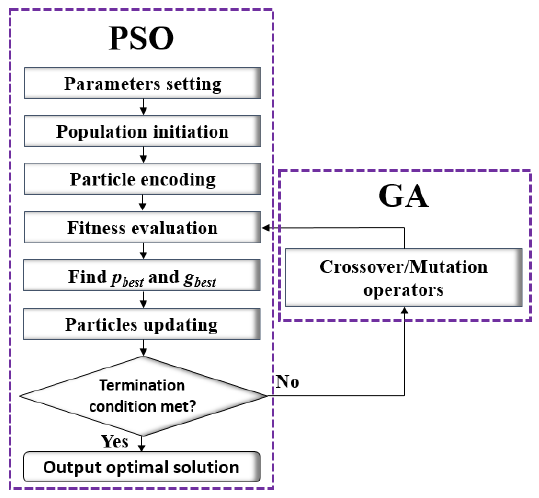
Figure 8. Flow chart of MP-PSOGA.